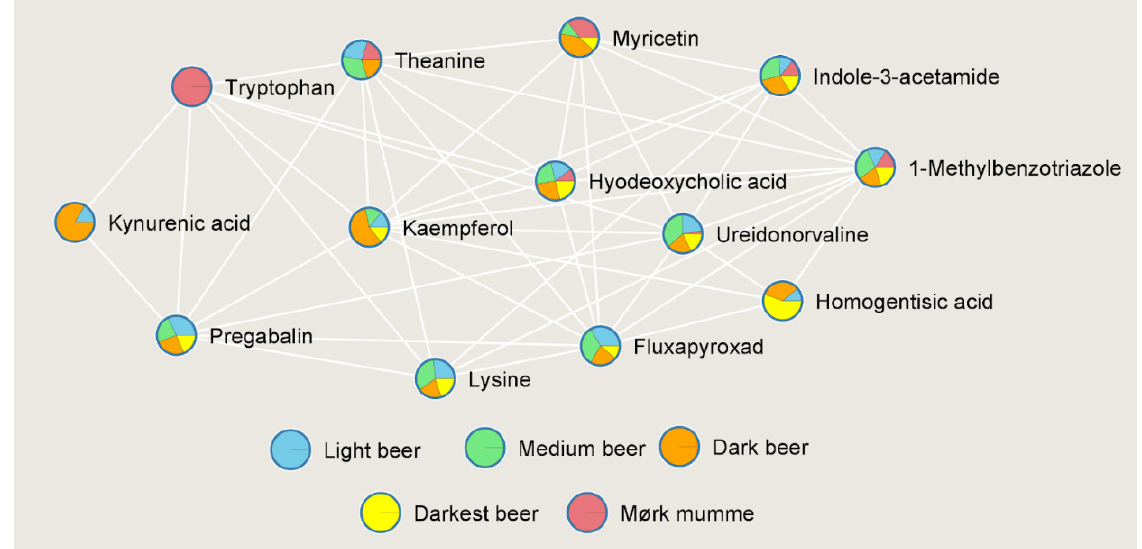
Figure 1. Curated molecular subnetwork containing tryptophan, as generated from different beer samples.